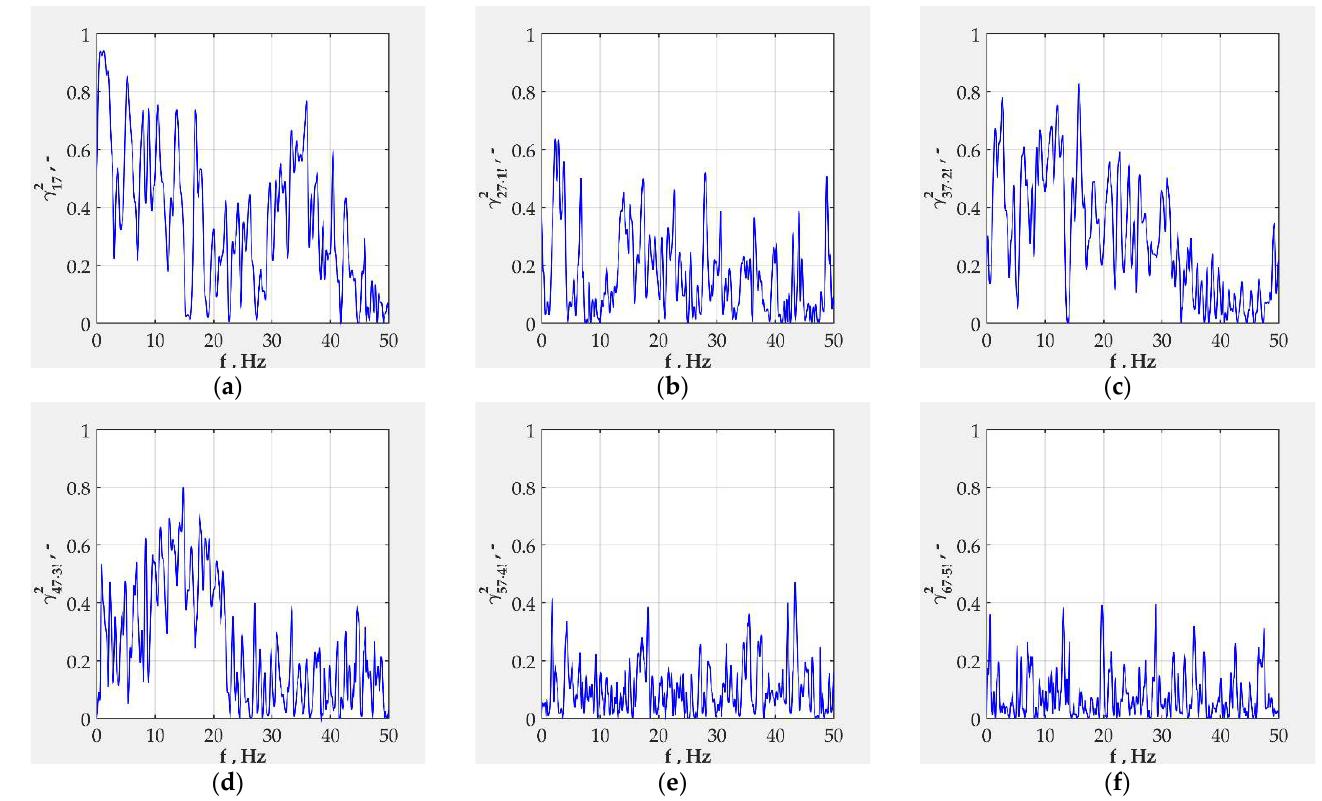
X for the Figure 13. Partial coherence functions between the conditioned inputs and the output X 7 for the 7